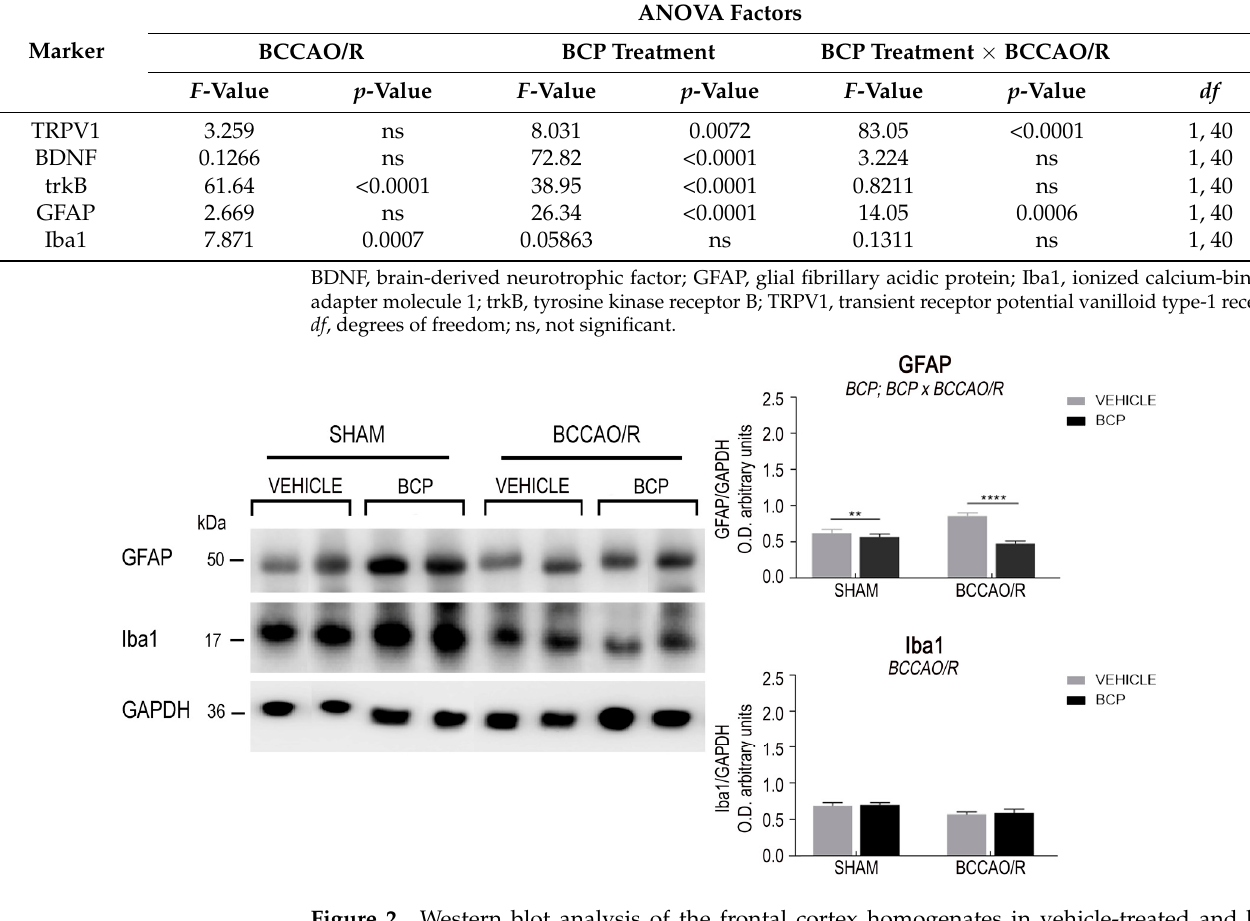
Figure 2. Western blot analysis of the frontal cortex homogenates in vehicle-treated and beta- caryophyllene (BCP)-treated rats either in sham-operated or after bilateral common carotid artery occlusion followed by reperfusion (BCCAO/R). ( Left ) Glial fibrillary acidic protein (GFAP), ionized calcium-binding adapter molecule 1 (Iba1), glyceraldehyde-3-phosphate dehydrogenase (GAPDH) proteins. ( Right ) Densitometric analysis of the band gray levels expressed as a percentage of the opti- cal density (O.D.) ratio of GFAP- and Iba1-positive bands to those immunostained for GAPDH. Data are reported as the mean values of 12 vehicle-treated and 10 BCP-treated rats for each experimental condition. Error bars depict the standard error of the mean (S.E.M.). Asterisks denote significant differences. Two-way ANOVA with the Tukey’s test for post-hoc analyses was applied to evaluate statistical differences between groups. BCCAO/R , significant effect of BCCAO/R; BCP , significant effect of BCP-treatment; BCP × BCCAO/R , significant BCP-treatment × BCCAO/R interaction. ** p < 0.01; **** p ≤ 0.0001 (see Table 1 for F -values and p -values relevant to effects of BCCAO/R and BCP pre-treatment and to the interaction between